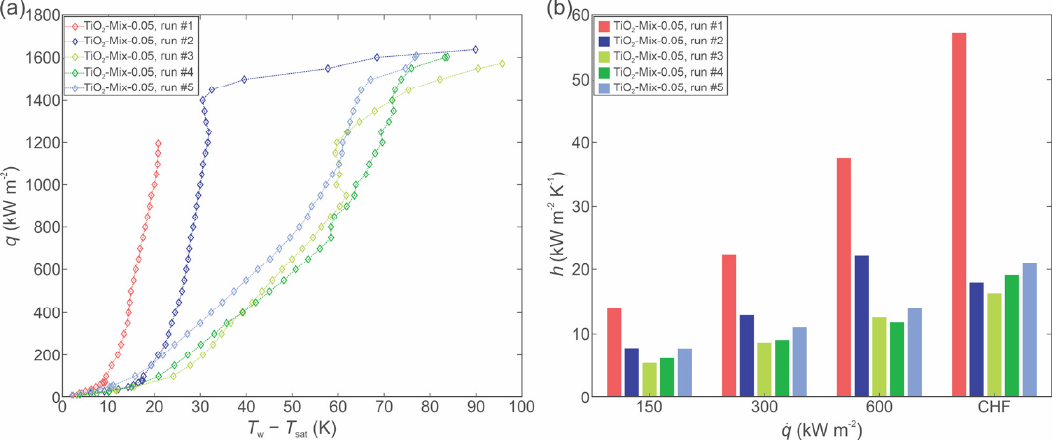
Figure 10. Boiling of TiO 2 -water nanofluid with 0.05 wt.% of small size and 0.05 wt.% large size nanoparticles, respectively: boiling curves ( a ) and heat transfer coefficients ( b ).